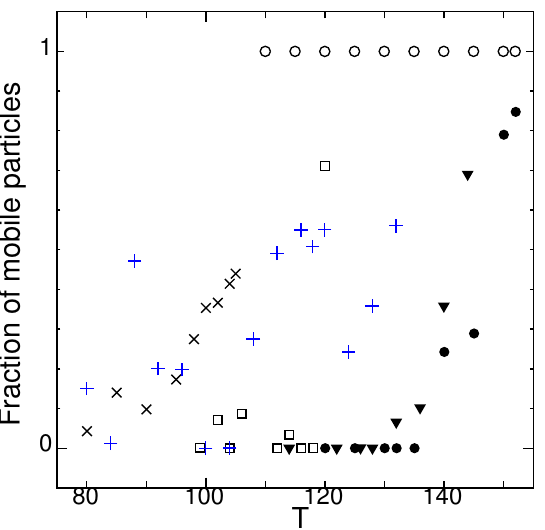
Figure 2. Temperature dependence of fraction of mobile particles of states G ( ▼ ), J ( ◻ ), M ( × ), O (blue + ), and crystal ( ● ), and supercooled liquid ( ○ ) measured in time duration of ∆ t = 1000 for system size N =